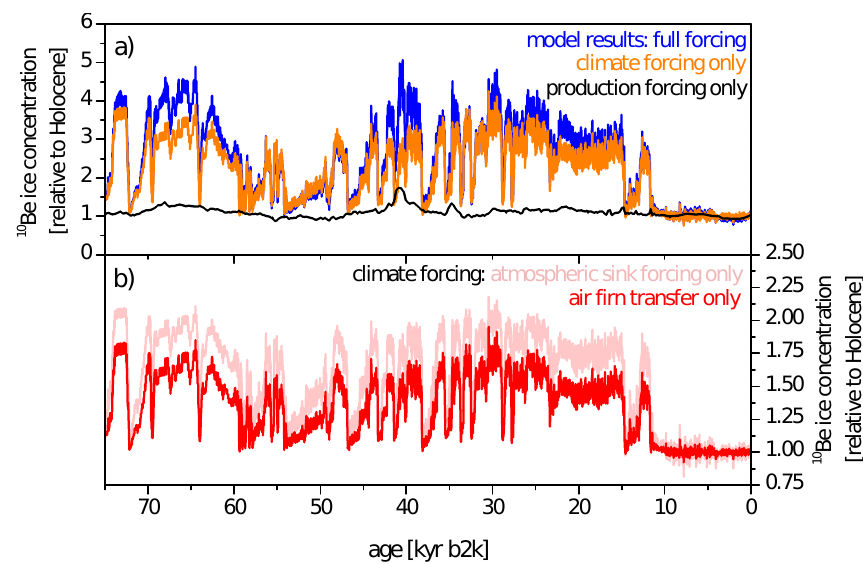
Figure 8. Sensitivity of Greenland Summit 10 Be ice concentration model results with respect to different influencing processes. (a) Model results using constant geomagnetic activity (climate forcing only, orange) compared to model results with constant precipitation/snow accu- mulation rate (production forcing only, black) and full forcing (blue). (b) Breakdown of climate modulation into air–firn transfer (red) and atmospheric sink strength (light